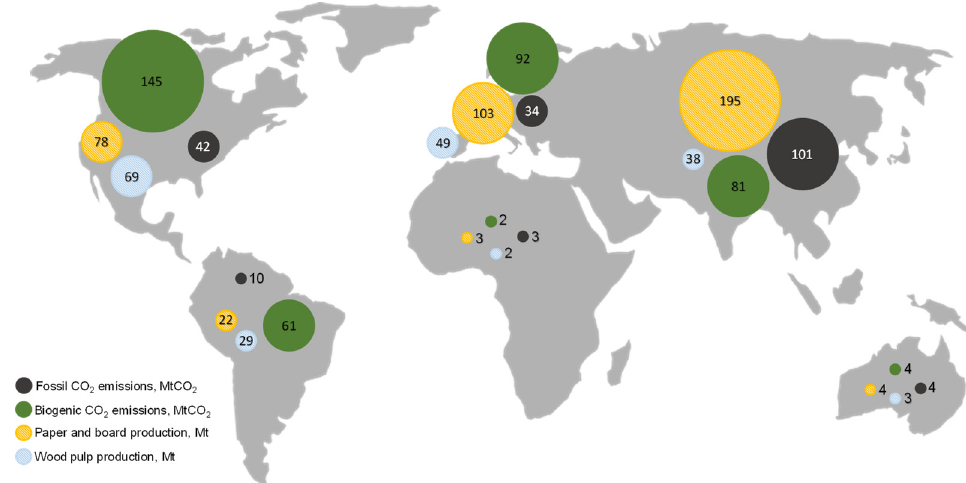
Figure 6. The geographical distribution of CO 2 emissions and production volumes of the global pulp and paper industry.